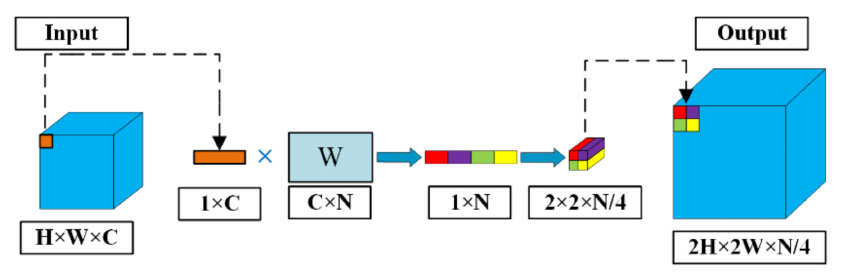
Figure 3. Pipeline of